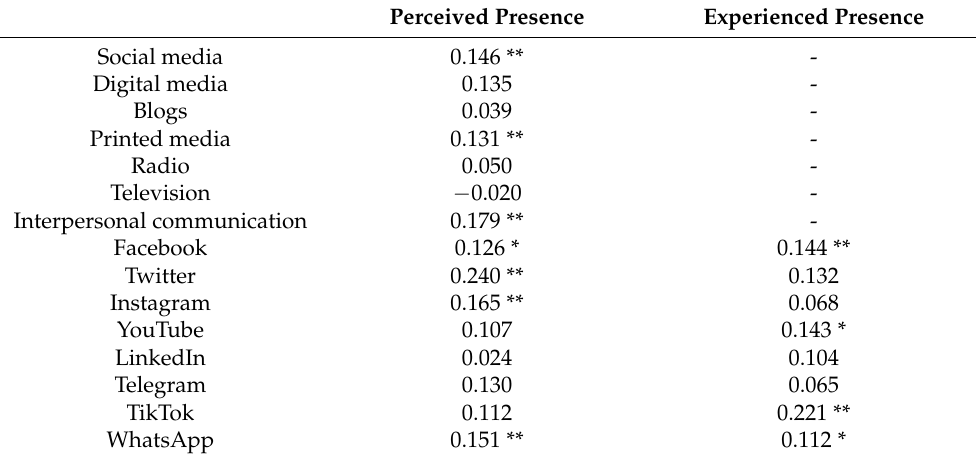
Table 2. Correlations between frequency of use and perceived and experienced presence of fake news in different